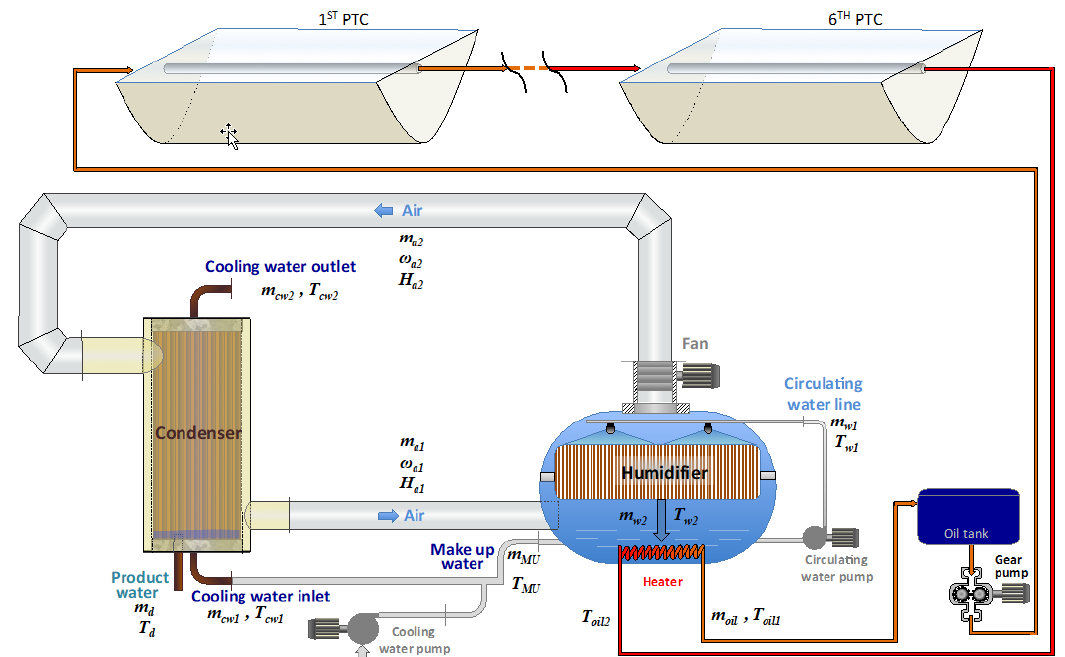
Figure 2. Schematic diagram of the humidifier.